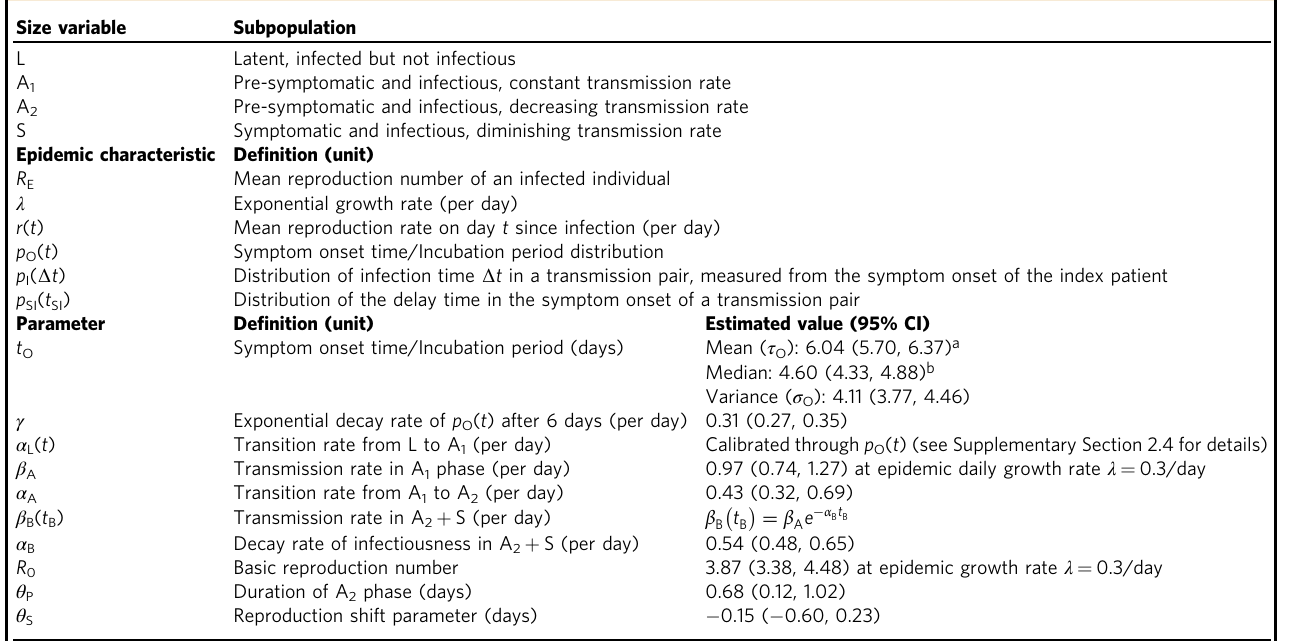
Table 1 Key variables and parameters of the compartmentalised